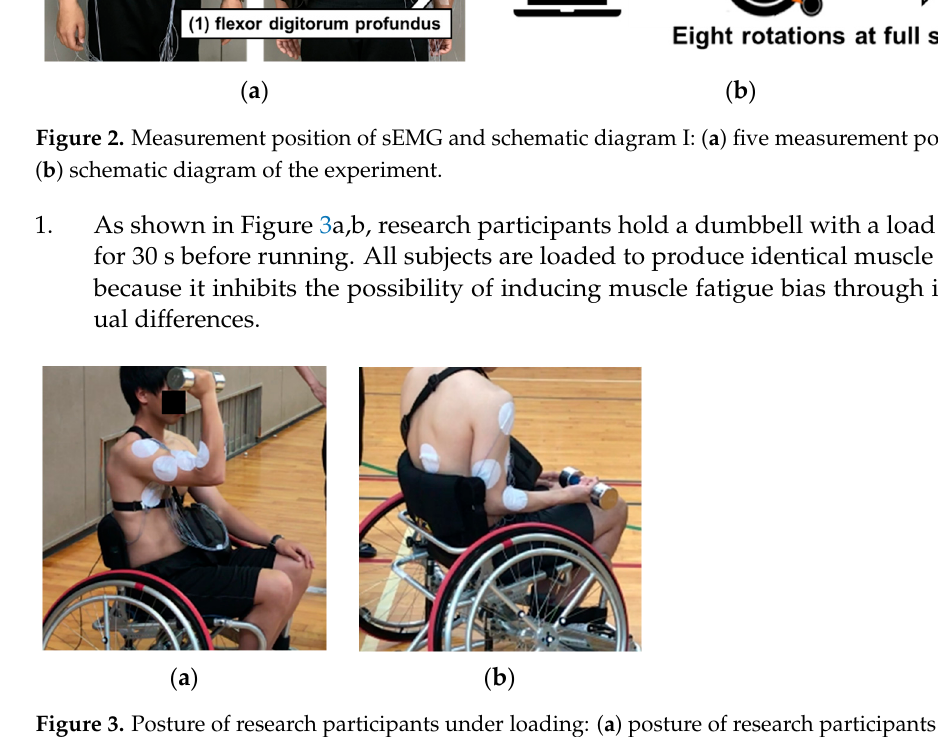
Figure 3. Posture of research participants under loading: ( a ) posture of research participants holding the dumbbells Part 1 and ( b ) posture of research participants holding the dumbbells Part